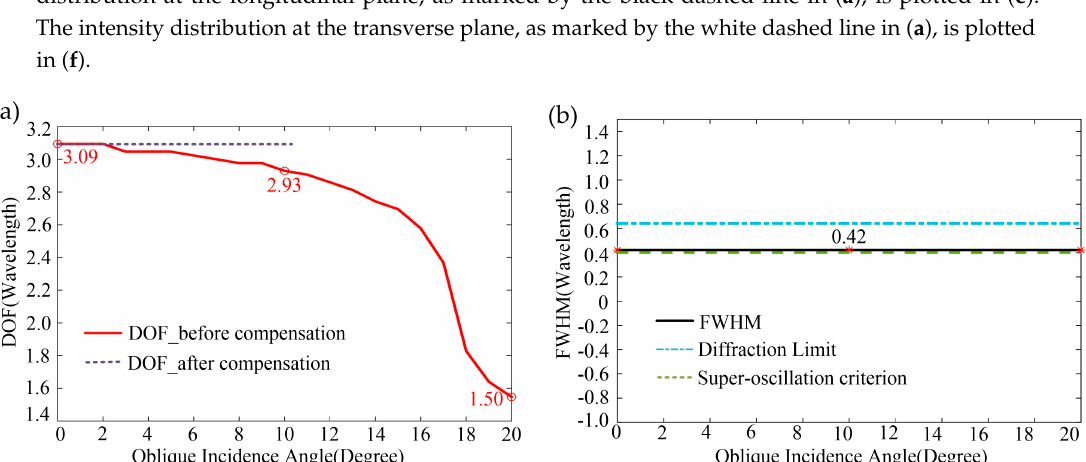
Figure 5. ( a ) The depth of focus (DOF) of the movable super-diffraction optical needle (MSON) before and after phase compensation. The red curve denotes the DOF before compensation, and the purple dotted line denotes the DOF after compensation. ( b ) The full width at half-maximum (FWHM) of the MSON. The black line denotes the FWHM, the blue dashed line denotes the diffraction limit, and the green dashed line denotes the super-oscillation criterion of the lens.